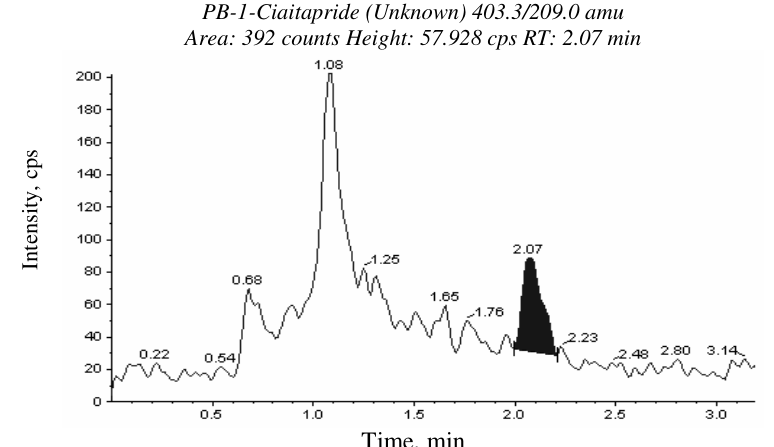
Figure 1. Representative chromatograms plasma blank for cinitapride drug